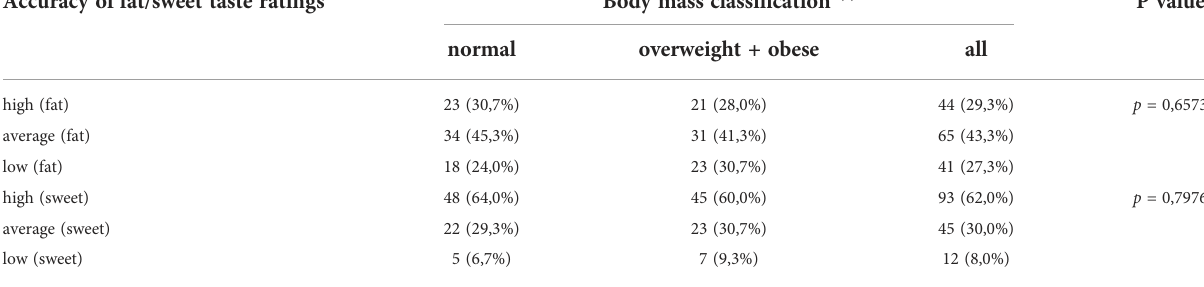
TABLE 1 Accuracy of children ’ s taste perception according to body mass